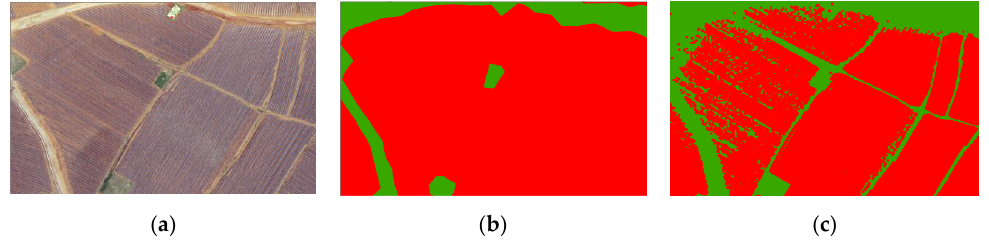
Figure 6. The impact of core size on the dilation operation. ( a ) UAV image; ( b ) dilation with a too large core size; ( c ) dilation with a too small core size.